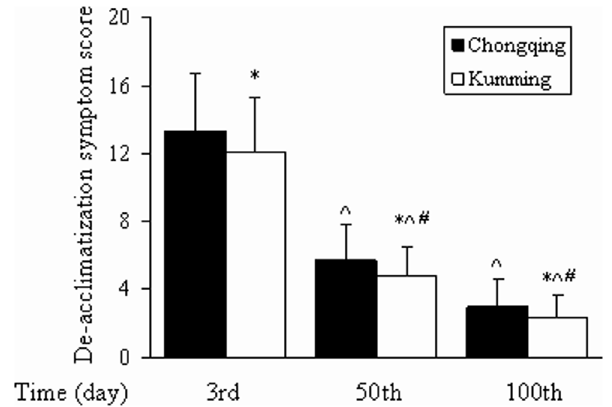
Figure 1. Symptom scores. Data are presented as mean 6 SD. * P , 0.05, relative to the Chongqing group.ˆ P , 0.05, relative to the 3 rd day, # P , 0.05, relative to the 50 th day.